Question: Summarize what this figure shows in one sentence.
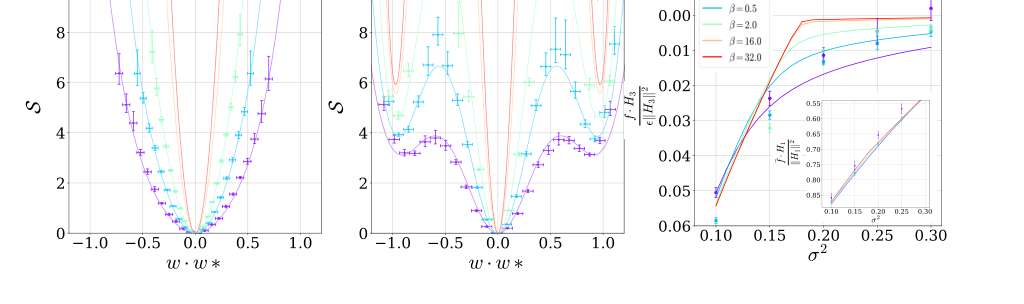
Answer: GFL to GMFL-I Theory and Experiment in the teacher-student model. Panel (a) and (b) show the negative log posterior before and after the phase transition induced by varying the noise σ2. A good match with the experimental values (crosses) and theory (solid lines) for rarer and rarer events is obtained as we scale up the model according to Table 1. (colour coding). Turning to network outputs, panel (c) shows the expected phase transition in learning the cubic teacher component and the inset shows the discrepancy in the linear teacher component. As our analytics holds before and at the phase transitions, discrepancies in ¯f · H3 close to the transition are an expected finite-size effect made pronounced by its low absolute value.